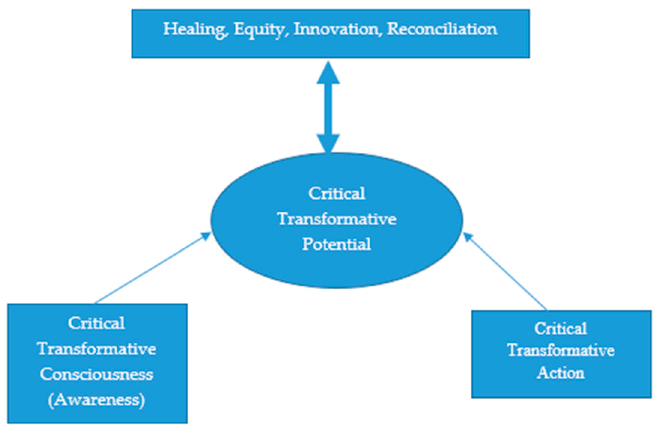
Figure 3. The Critical Transformative Potential Model. Note. Figure 3 depicts the two dimensions of Critical Transformative Potential.